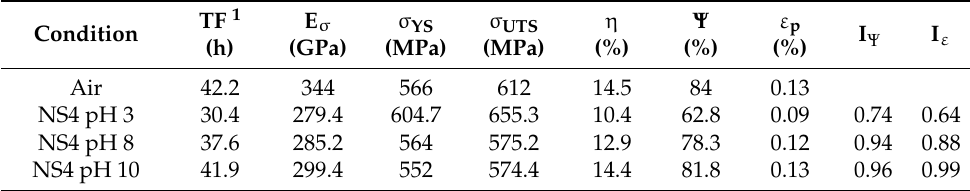
Table 2. Mechanical properties obtained from the SSRT